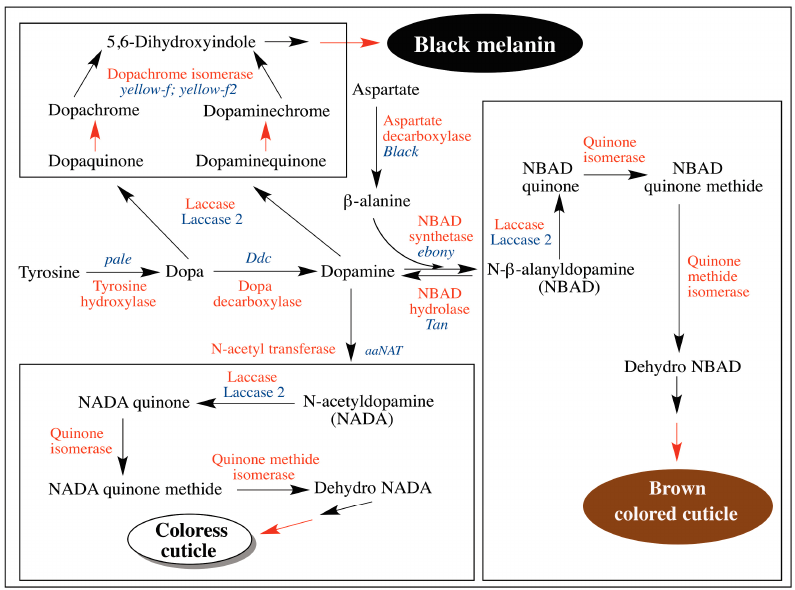
Figure 13. Genes associated with melanization and sclerotization processes in insect cuticle.